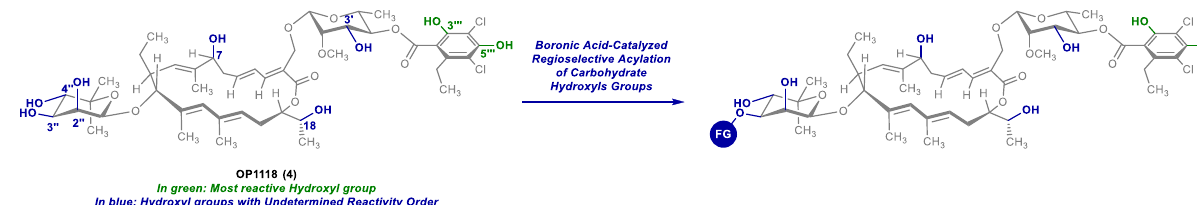
Fig. 4 Site-selective acylation of 4. Overview of the strategy.